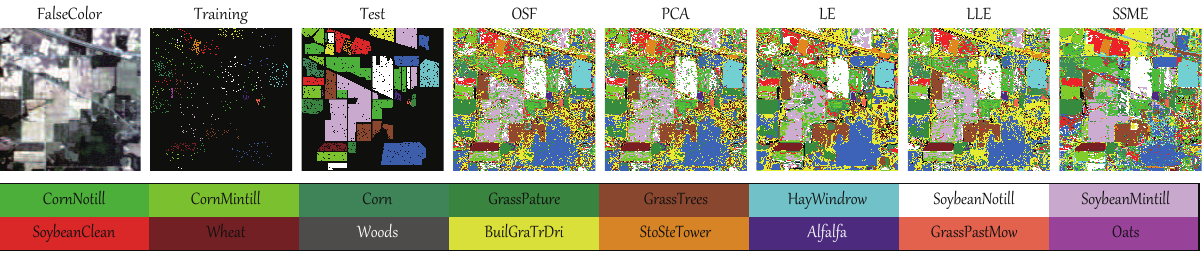
Figure 2. Classification maps obtained by different hyperspectral embedding approaches on the Indine Pines dataset. using our proposed SSME are higher than those using other competitors, as listed in Table